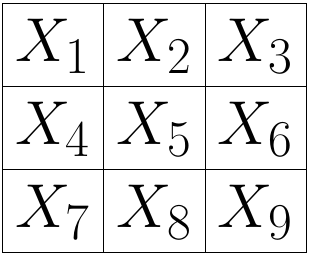
Figure 3 . An illustration of the classical magic-square game. Table 1 . Classical variables to fill the nine cells of the 3 × 3